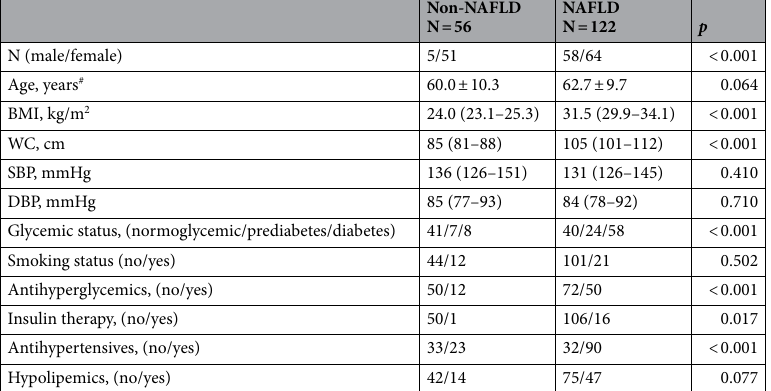
Table 1. General data of participants according to NAFLD status. Data are presented as median (interquartile range) and compared with Mann–Whitney U -test. # Normally distributed data are presented as arithmetic mean ± standard deviation and compared with Student t -test. Categorical variables are presented as absolute frequencies and compared by Chi-square test for contingency tables. BMI-Body mass index; WC-Waist circumference; SBP-Systolic blood pressure; DBP-Diastolic blood pressure.